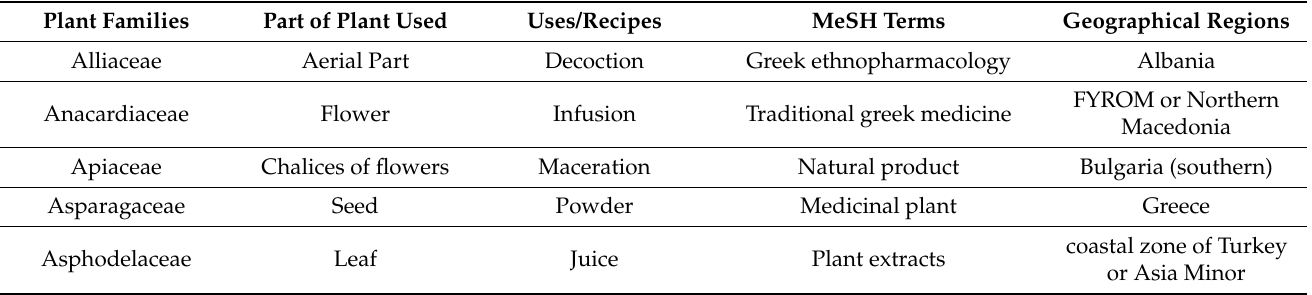
Table 1. Ethnopharmacological Topics/Mesh Terms used for our